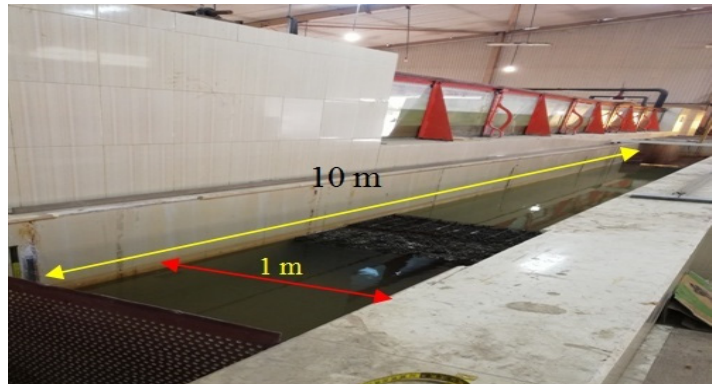
Figure 1. Canal used in the experimental study.